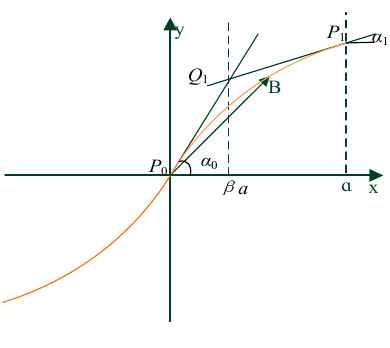
Figure 2. Quadratic Bezier curve.